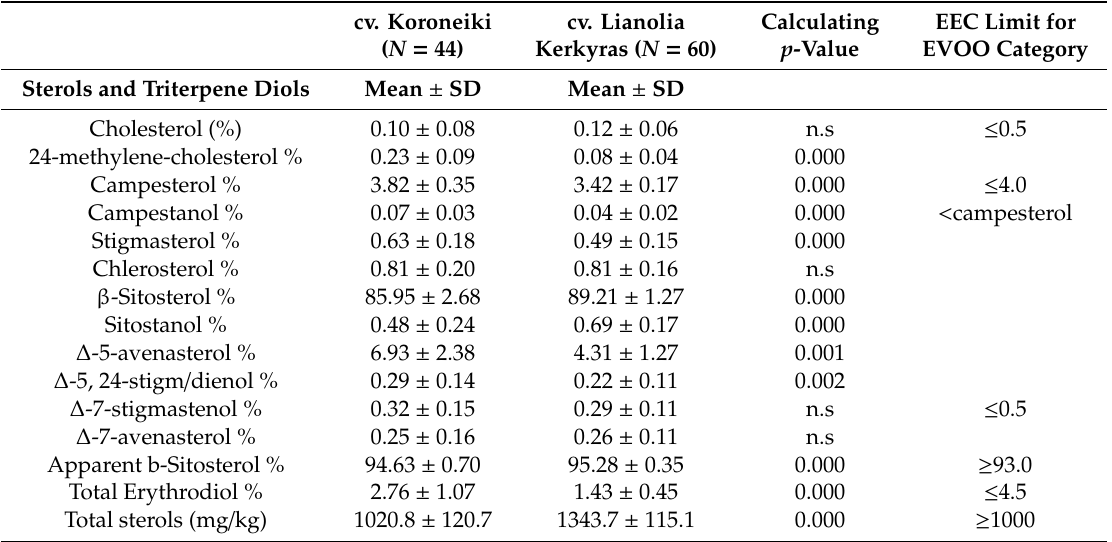
Values are expressed as means ± standard deviation (SD). n.s = not-significant. The p < 0.05 was set at the level of statistical significance.